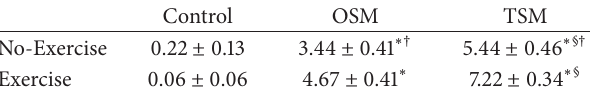
Table 2: Perceived sense of presence [absolute